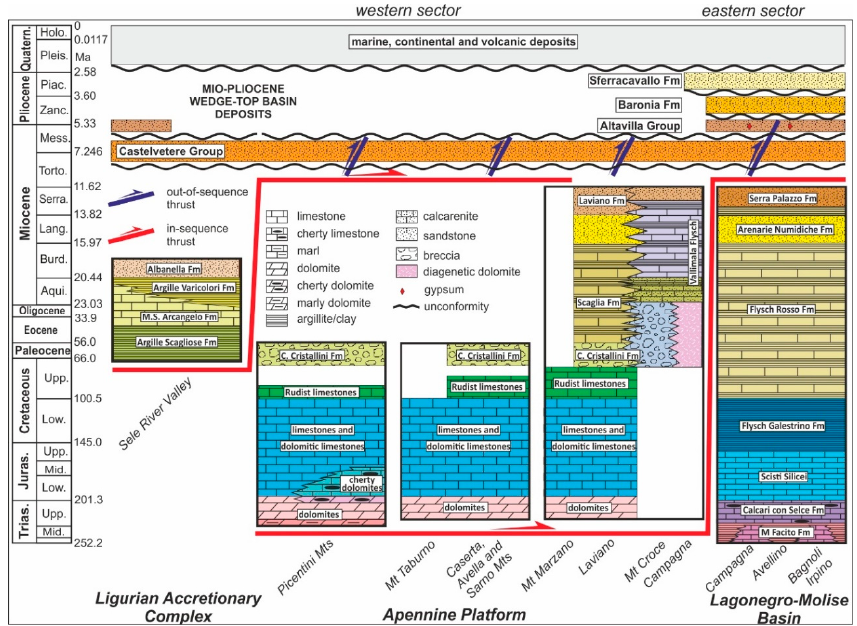
Figure 2. Schematic stratigraphic logs of the analyzed successions.